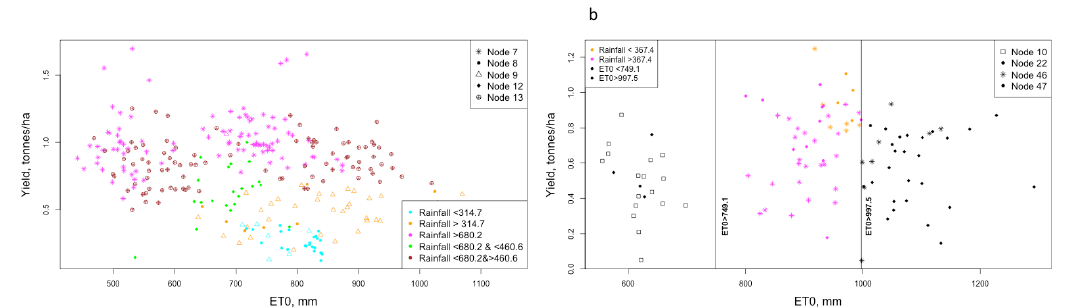
Figure 11. ( a ) The regression tree results for Burkina Faso, Mali, and Niger plotted with ET 0 against yield, with different dot shapes denoting which node in the regression tree the yield falls into. The dots are separated by different colors for the precipitation rules—for Burkina Faso and Mali, the precipitation greater than 680.2 mm is represented as pink, the precipitation between 680.2 mm and 460.6 mm is represented as dark red, and precipitation less than 460.6 is represented as green. For Niger, the precipitation greater than 314.7 mm is represented with blue, and the precipitation less than 314.7 is represented as orange. ( b ) The regression tree results for Senegal, plotting ET 0 against yield, with different dot shapes representing which node in the regression tree the yield falls into. The dots are separated by different colors for the precipitation rules, and there are lines representing the ET 0 rules. The first rule is ET 0 greater (less) than 749.1 mm, and the second rule is ET 0 greater (less) than 997.5 mm. The next rule is precipitation greater than 367.4 mm (represented by pink) and precipitation less than 367.4 mm (represented by